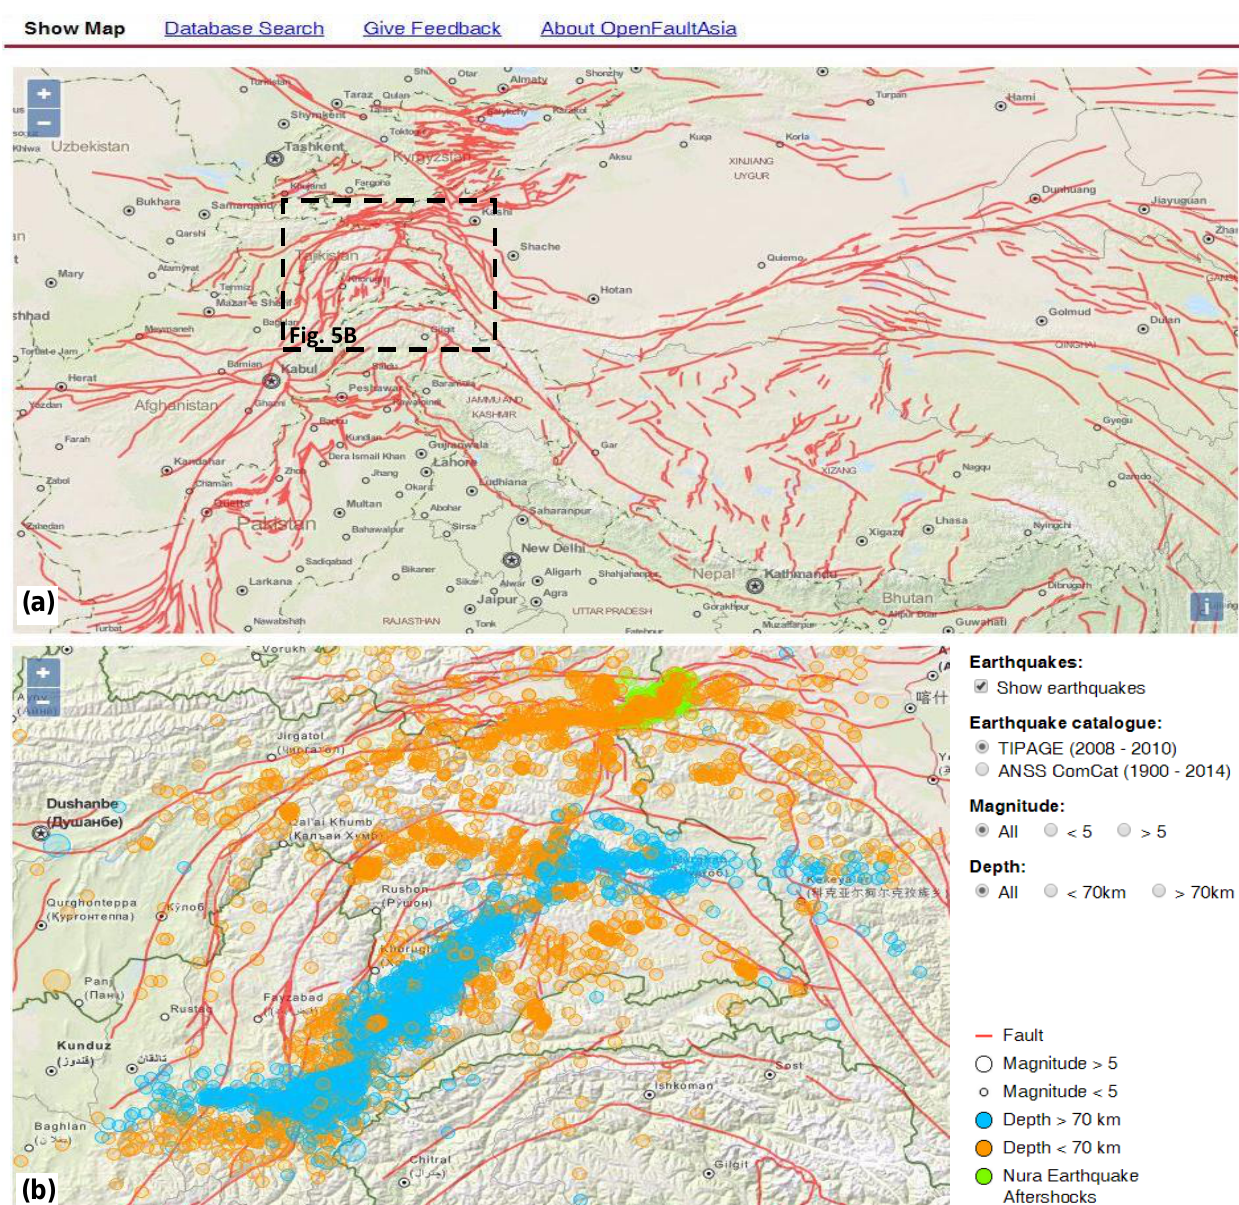
Figure 5. The database interface includes an interactive fault map with faults shown in red (a) . Example of a map display with earthquake data set from Sippl et al. (2013) is shown for the Pamir and the Hindu Kush regions (b) . Black dashed box in (a) shows the map extent displayed in (b)